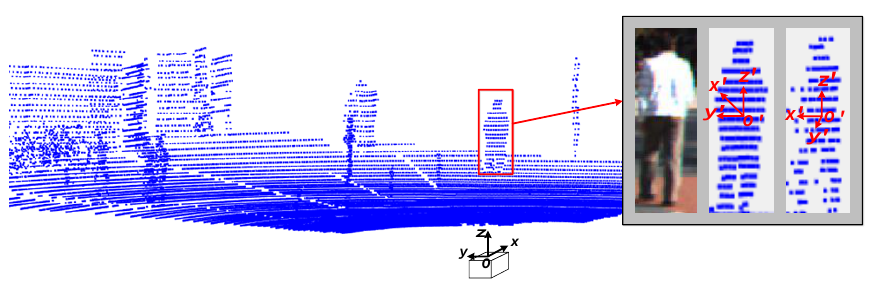
Figure 2. Pedestrian-detection coordinates. Oxyz , Lidar coordinate system; O (cid:48) x (cid:48) y (cid:48) z (cid:48) , local coordinate system.